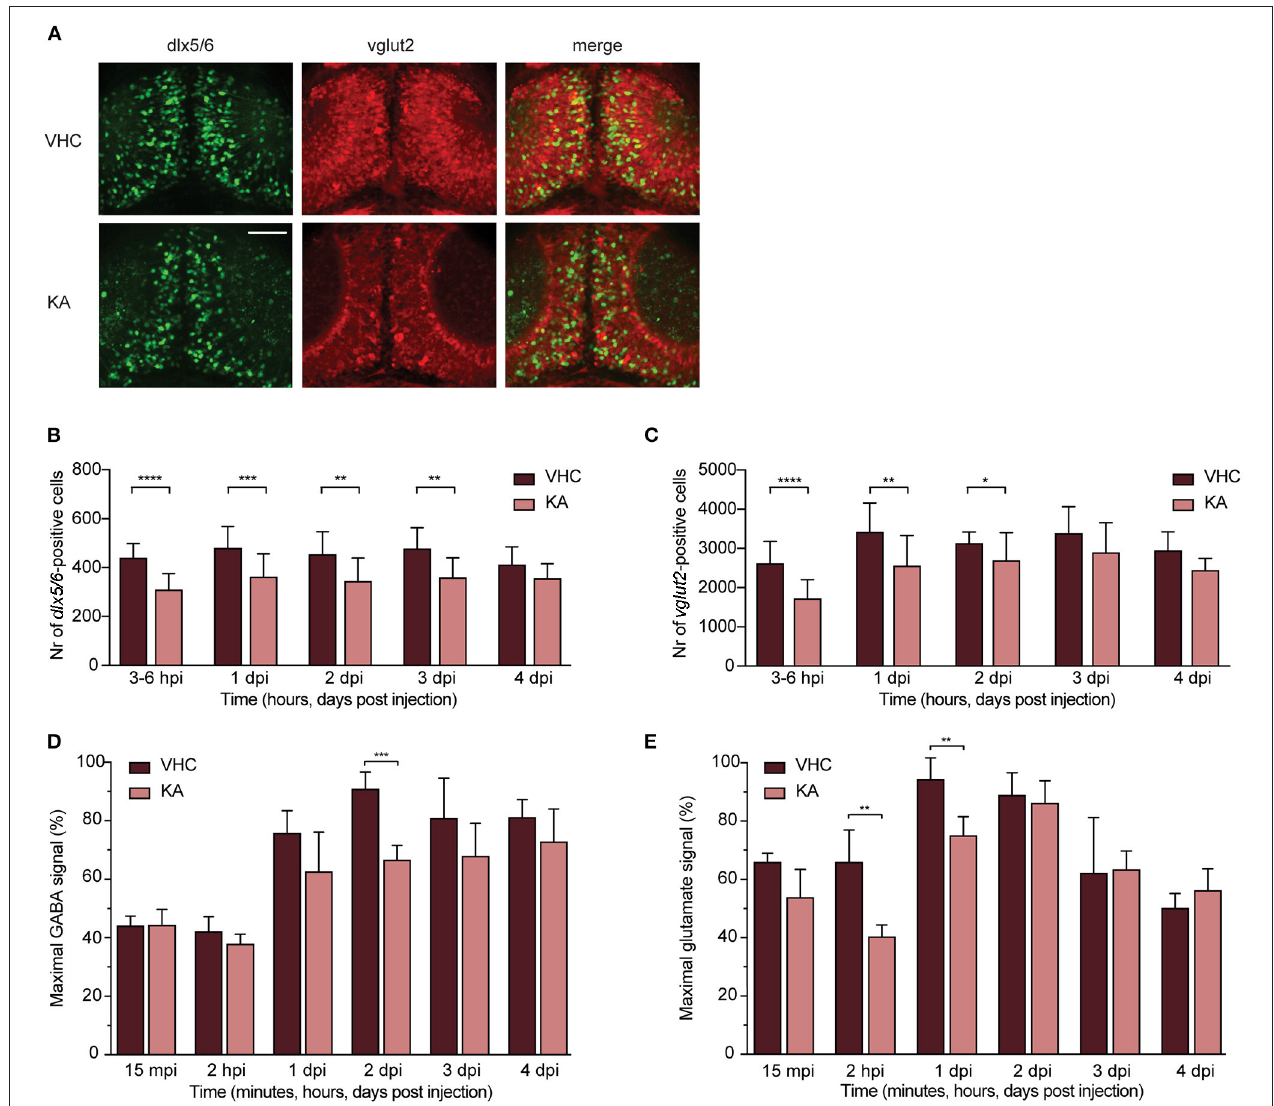
FIGURE 5 | GABAergic and glutamatergic neuronal populations and neurotransmitters levels in kainic acid-injected larvae demonstrate a decrease. (A) Representative images of the GABAergic and glutamatergic neurons in transgenic reporter lines in 3–6 hpi VHC- and KA-injected larvae. Scale bar 50 µ m. (B) Statistically significant decrease in the number of dlx5/6 -positive cells was observed from 3–6 hpi until 3 dpi (** p < 0.01, *** p < 0.001, **** p < 0.0001). (C) Statistically significant decreases in the number of vglut2 -positive cells were observed from 3–6 hpi until 2 dpi (* p < 0.05, ** p < 0.01, **** p < 0.0001). Data in (B,C) are presented as mean ± s.d. Total number of larvae per condition: 3–6 hpi VHC n = 20, KA n = 15; 1 dpi VHC n = 17, KA n = 16; 2 dpi VHC n = 16, KA n = 18; 3dpi VHC n = 13, KA n = 14; 4 dpi VHC n = 6, KA n = 6. Statistical analysis was performed using unpaired t -test. LC-MS/MS analysis of GABA (D) and glutamate (E) levels in the larval brains at 15 mpi, 2 hpi and 1–4 dpi. (D) Statistical reduction in GABA levels between VHC- and KA-injected larvae was observed at 2 dpi (*** p < 0.001), (E) while in glutamate levels at 2 hpi (** p < 0.01) and 1 dpi (** p < 0.01). Maximal signal (%) in (D,E) refers to the highest signal found among measured samples per each neurotransmitter. Data from four independent experiments are presented as mean ± s.d. Statistical analysis was performed using unpaired t -test.